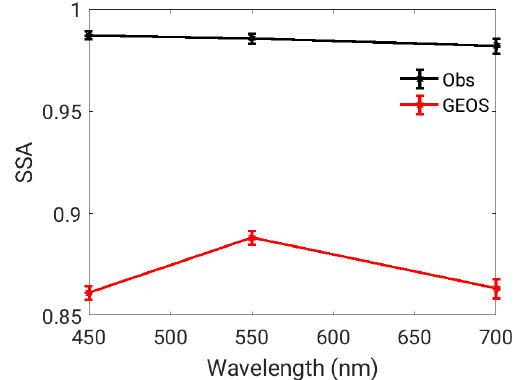
Figure 12. Mean dry single-scattering albedo at 450, 550, and 700nm from GEOS and the LARGE observations for the flight tran- sect from RF9. Error bars indicate 1 standard deviation from the mean.